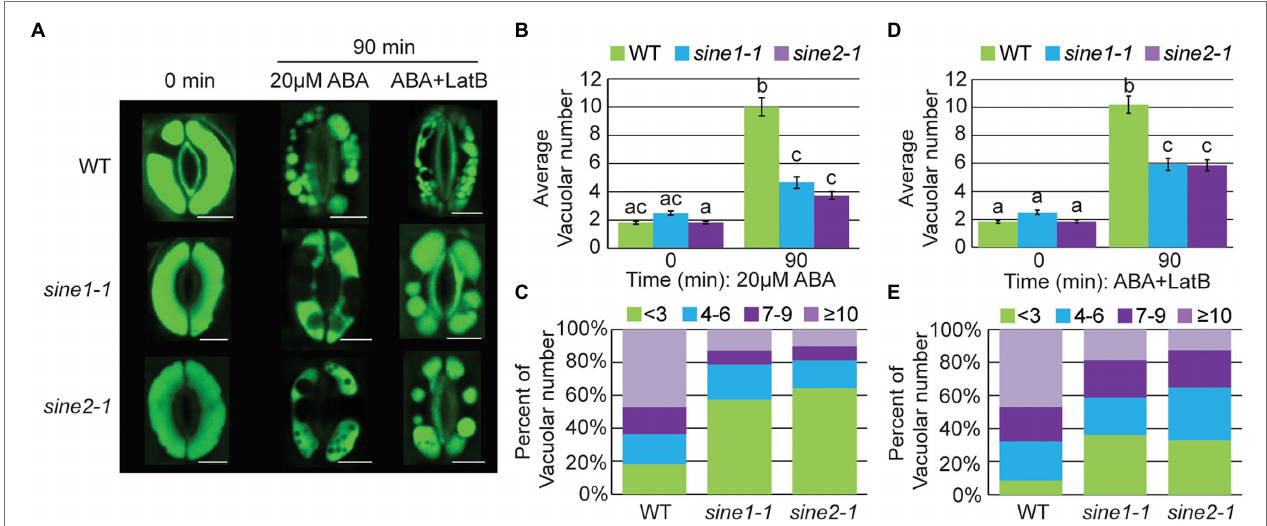
FIGURE 6 | Vacuolar fragmentation is compromised during ABA-induced stomatal closure in sine mutants owing, in part, to disruptions in actin organization. (A) Representative images of vacuolar morphology at 0 and 90 min after addition of either 20 μ M ABA or 20 μ M ABA +10 μ M LatB. Scale bars = 5 μ m. (B,D) Average vacuolar number seen in guard cells before and after treatment with (B) 20 μ M ABA or (D) 20 μ M ABA +10 μ M LatB. Statistical significance was calculated using one-way ANOVA followed by a post hoc Tukey HSD test. Lowercase letters denote groups that are statistically different ( p < 0.01). Data are mean values ± SE from three independent experiments. The number of stomata analyzed for each line is ≥ 68 guard cells. (C,E) Distribution of distinct vacuolar structures observed in guard cells after 90 min of treatment with either (C) 20 μ M ABA or (E) 20 μ M ABA +10 μ M LatB.